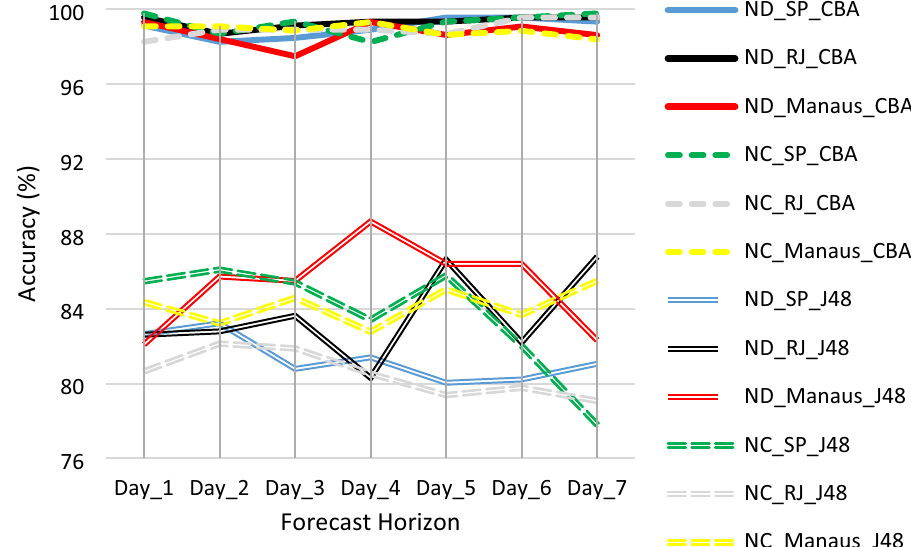
Figure 5. Accuracy comparison of the CBA and J48 prediction